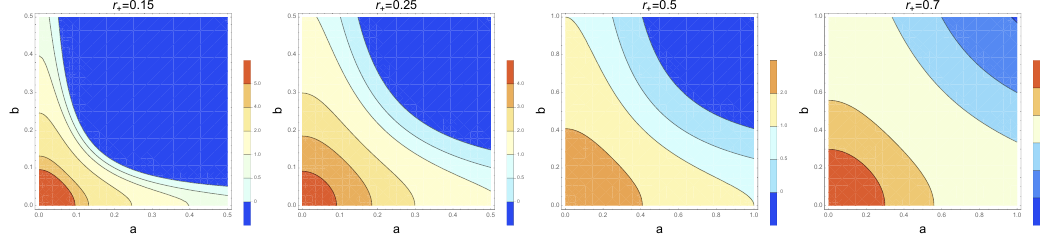
Figure 4 . Contour plot of the Hawking temperature (2.36) multiplied by 2 π · 2 . 9 depending on a, b and r +